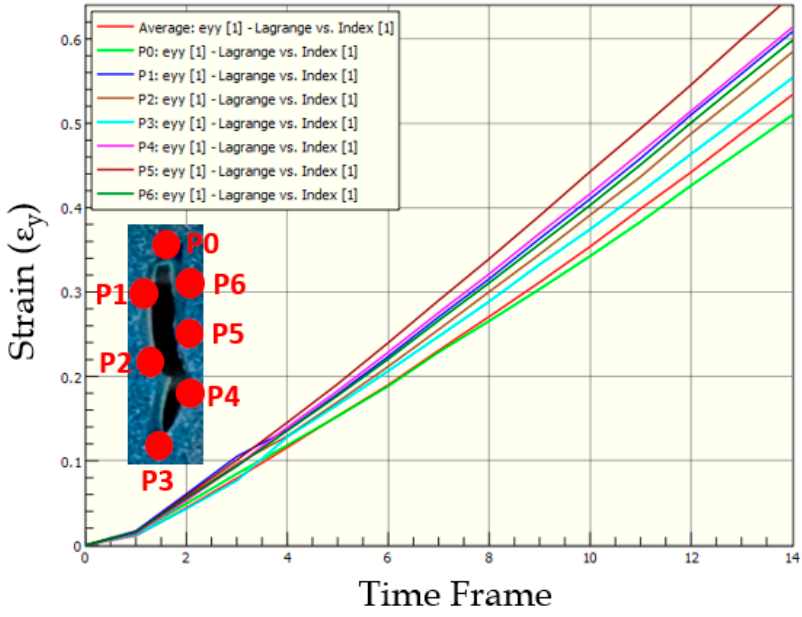
Figure 13. Average strain (y ‐ axis) versus time frame (x ‐ axis) measured using DIC from tensile test on the skin phantom specimen 3 with wound.